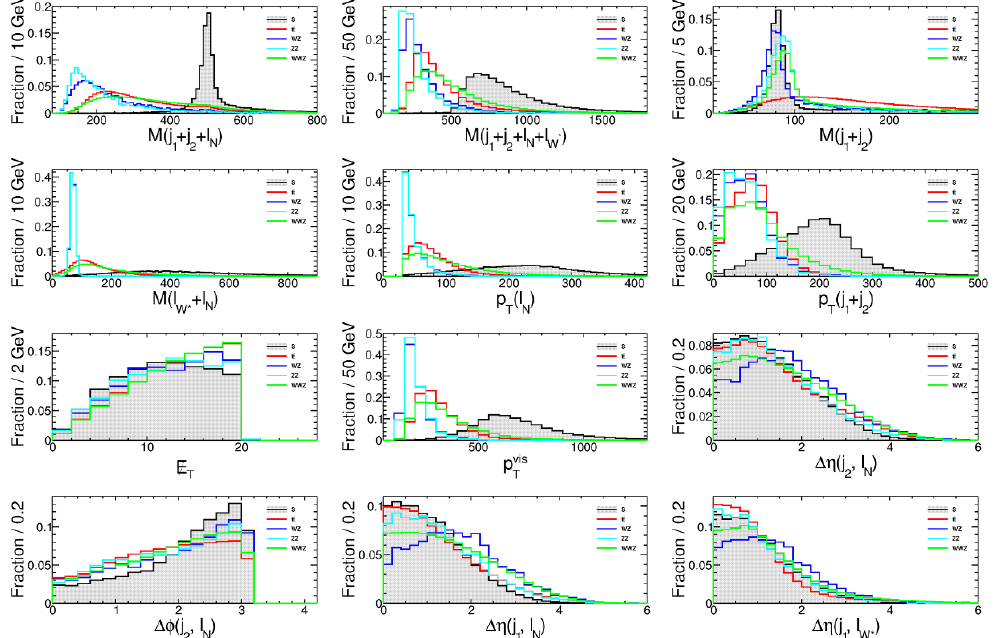
Figure 8 . Kinematic distributions of some selected observables for the signal with M N = 500 GeV (S, black with (cid:12)lled area), and for SM background processes of t (cid:22) t (red), WZ (blue), ZZ (cyan), and WWZ (green) after applying the pre-selection cuts at the HL-LHC.